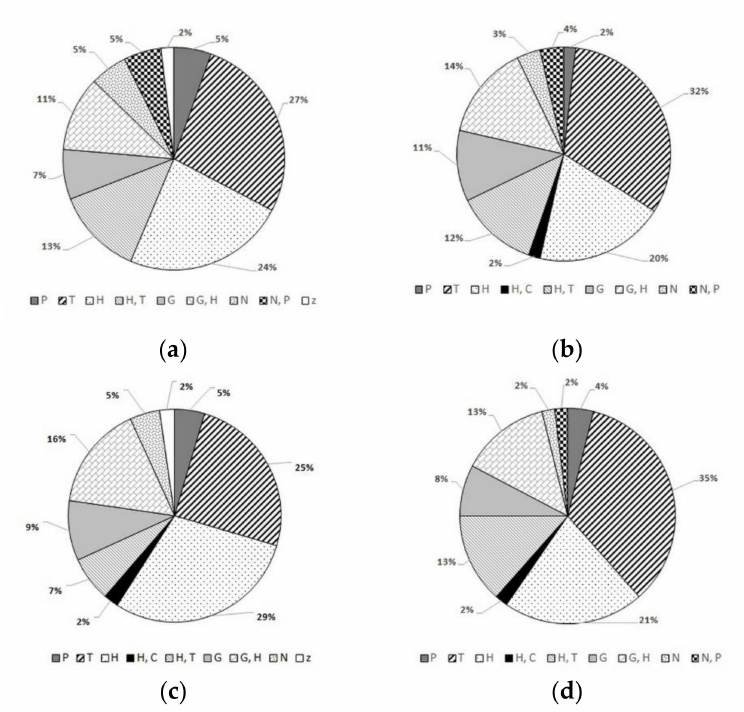
Figure 1. Ground-layer vegetation groups by life form for ( a ) Tordis, ( b ) Inger, ( c ) Pegaso, ( d ) and Miscanthus. P, phanerophytes; T, therophytes; H, hemicryptophytes; H / C, transient group hemicryptophytes and cryptophytes; H / T, transient group hemicryptophytes and therophytes; G, geophytes; G / H, transient group geophytes and hemicryptophytes; N, nanophanerophytes; N / P, transient group nanophanerophytes and phanerophytes; z,